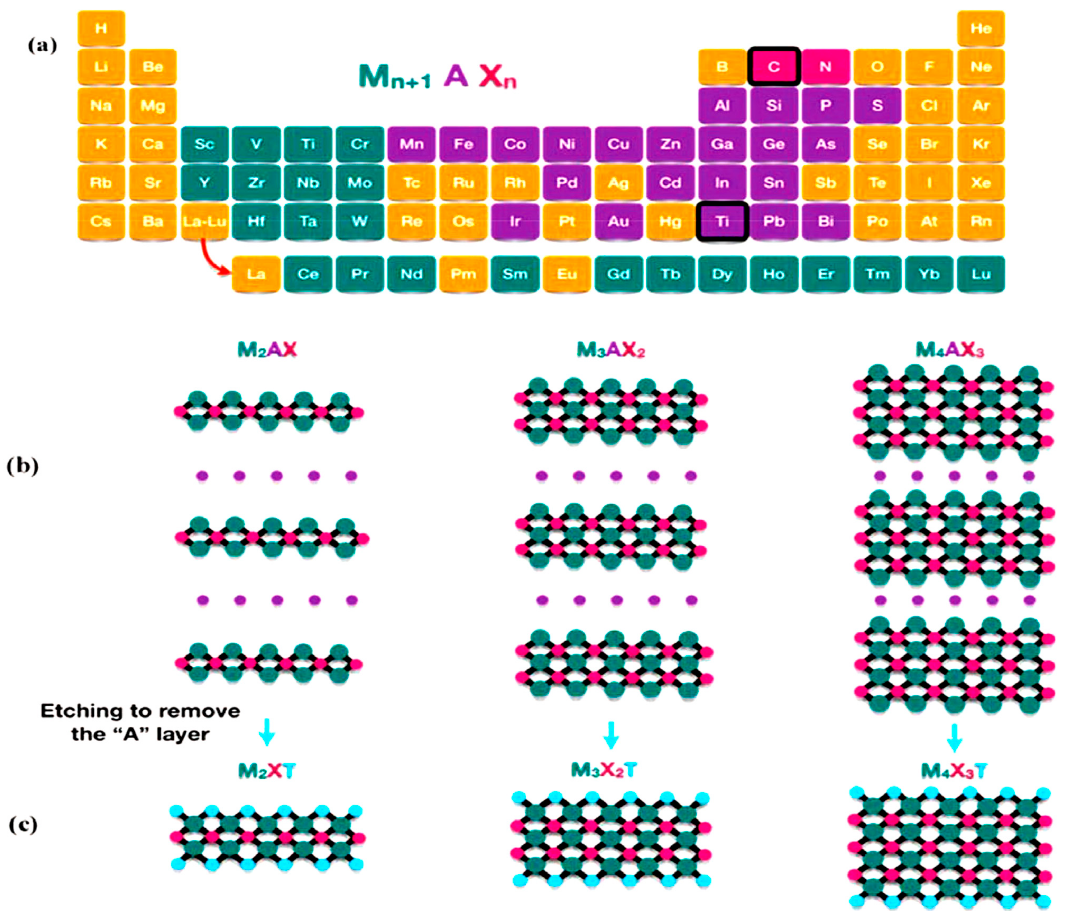
Figure 2. ( a ) Composition of MXene (M, A, and X represent the transition metal in green, group IIIA or IVA elements in purple, and nitrogen/carbon or both in red), ( b ) MAX-phase structures, and ( c ) MXenes